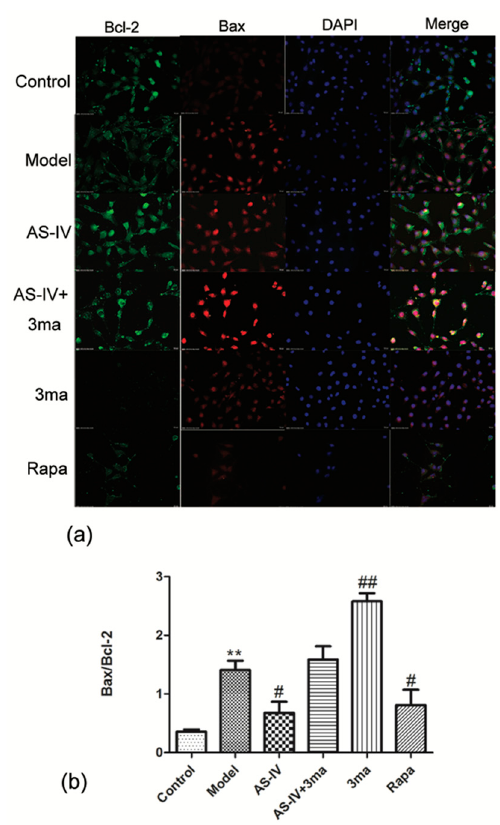
Figure 8. Astragaloside IV reduced Bax/Bcl-2 by activating autophagy after OGD/R and immunofluorescence staining for Bax and Bcl-2 of HT22 cells by OGD/R (means ± SD, n = 3. ** p < 0.01 vs. control and # p < 0.05, ## p < 0.01 vs. model; scale bar = 20 µm). Fluorescent images: Green, Bcl-2; red, Bax; and blue, DAPI. ( a ) Representative photographs obtained from each group. ( b ) Quantitative assessment of Bax/Bcl-2.